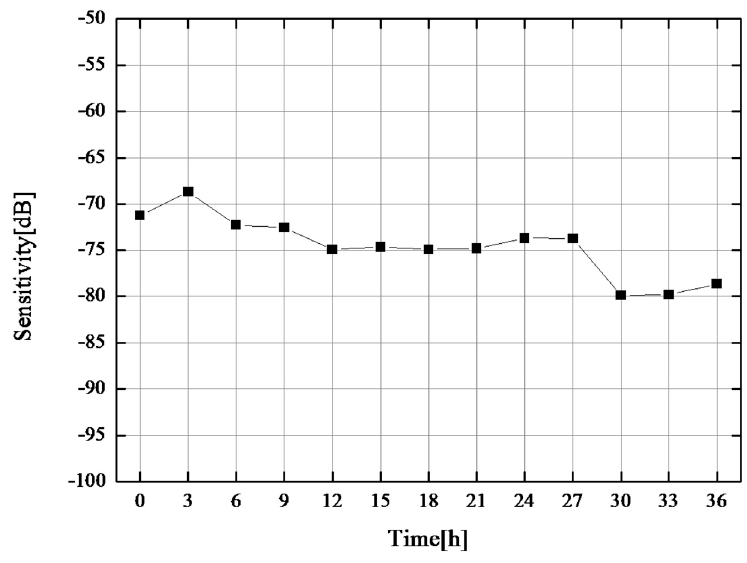
Figure 7. Sensitivity at 600 °C during the thermal durability test for 36 h.